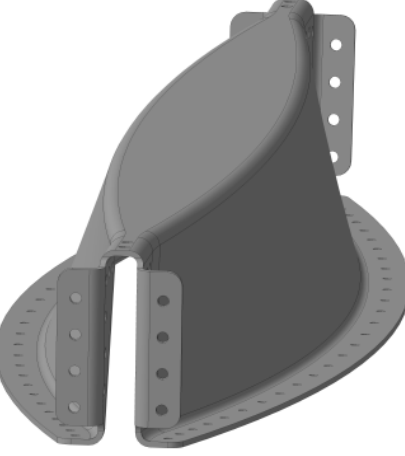
Figure 2. Optimized Omega profile.